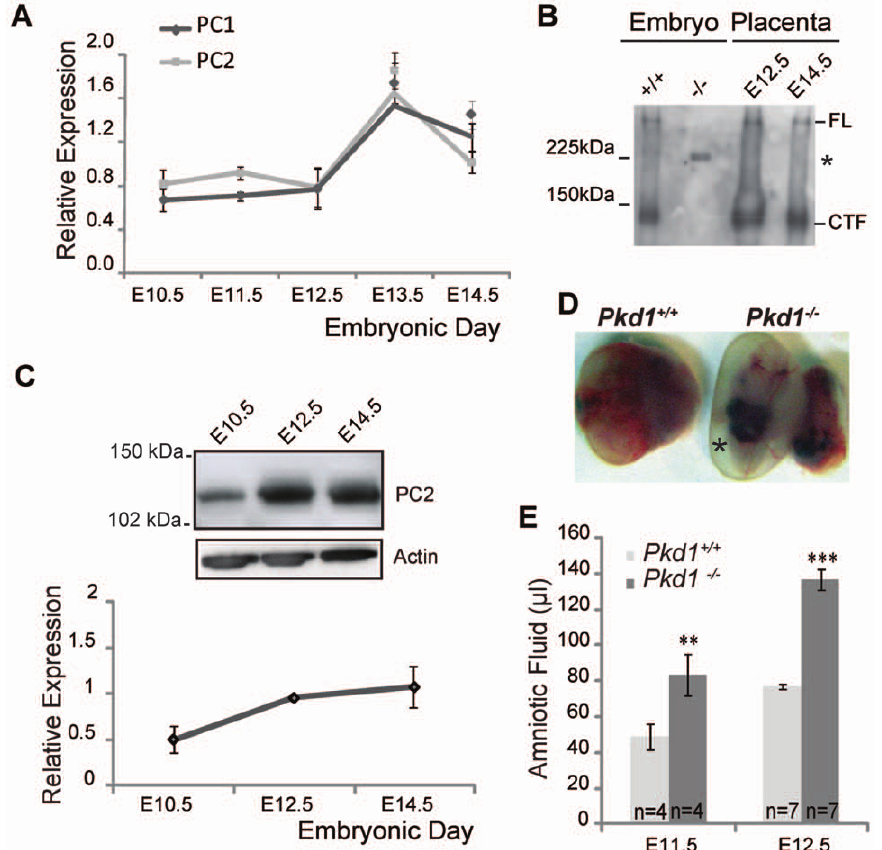
Figure 1. Coordinate Expression of PC1 and PC2 in Murine Placentas. A. Expression of Pkd1 and Pkd2 in E10.5–E14.5 placentas assayed by quantitative RT-PCR, normalized to RPL13. N=4 placentas were analyzed at E10.5 and E14.5 and N=3 placentas at the other time points. B. Immunoprecipitation of PC1 from placentas harvested at E12.5 and E14.5 and E12.5 embryos using a chicken antibody directed at the PC1 C- terminus. PC1 was detected on Western by rabbit antisera also directed at the PC1 C-terminus. Full length PC1 (FL) and the PC1 C-terminal cleavage fragment (CTF) are absent in the Pkd1 2 / 2 embryo. The asterisk denotes a non-specific band previously described [46]. Pkd1 2 / 2 placentas were not used as a negative control since they would be expected to contain maternal PC1. C. Expression of PC2 by Western analysis in E10.5–E14.5 placentas. Expression level was normalized to actin. N=4 placentas analyzed at each time point. Inset shows a representative Western blot. D. Representative Pkd1 2 / 2 and littermate control ( Pkd1 + / + ) embryos harvested at E11.5. Asterisk indicates polyhydramnios. E. Quantification of amniotic fluid. Increased amniotic fluid can be detected in Pkd1 2 / 2 embryos as early as E11.5. ** p , .01, *** p , .001.